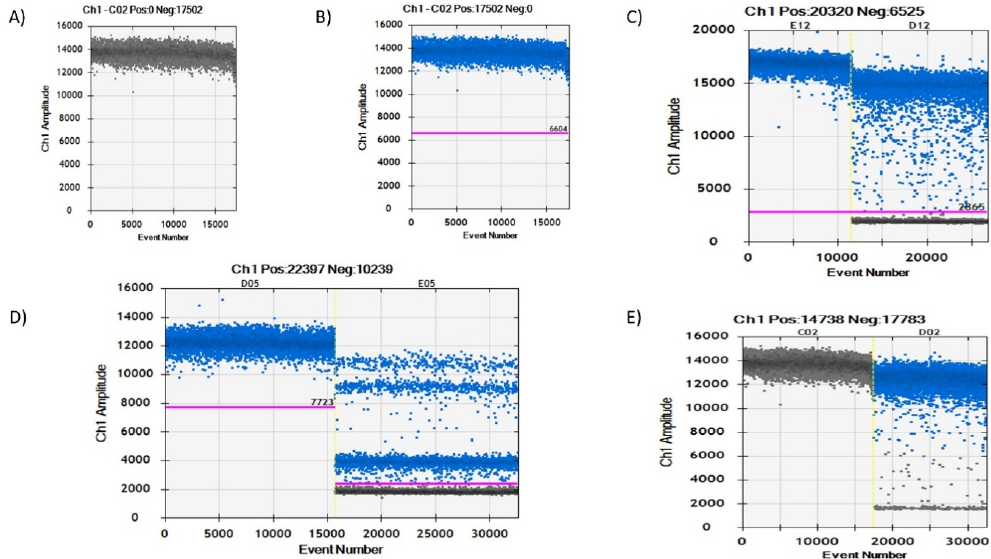
Figure 5. Droplet separation based on sample concentration. A and B represent the results of a highly concentrated sample based on automatic results (A) or manually generated results by thresholding (B) in the QuantaSoft™ software. C and E are the results of a simplex assay for high and low concentrated samples. D represents the duplex assay result of high (well D05) and low (well E05) concentrated samples.